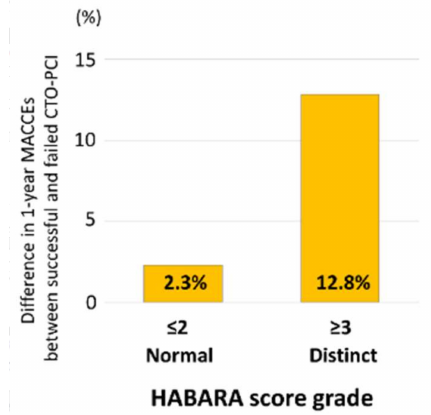
Figure 5. Di ff erence in one-year MACCEs between patients with successful CTO-PCI and those undergoing failed procedure, stratified by the HABARA score grade. Abbreviations: CTO, chronic total occlusion; HABARA, how aggressively the successful result of CTO-PCI should be achieved by the operator; MACCEs, major adverse cardiac and cerebrovascular events; PCI, percutaneous coronary